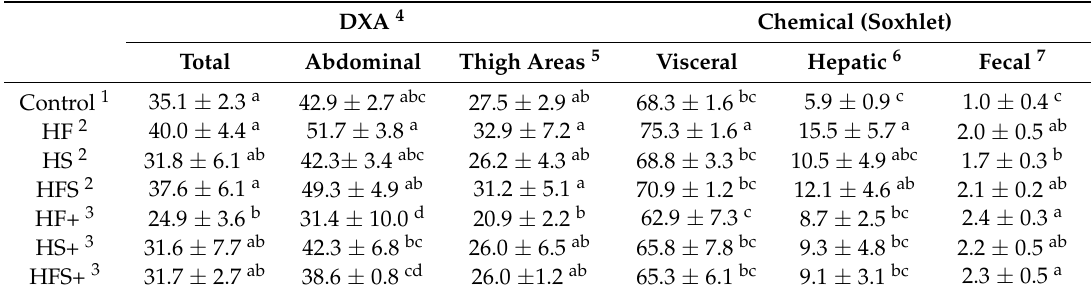
Table 4. Body fat distribution in rats fed with experimental